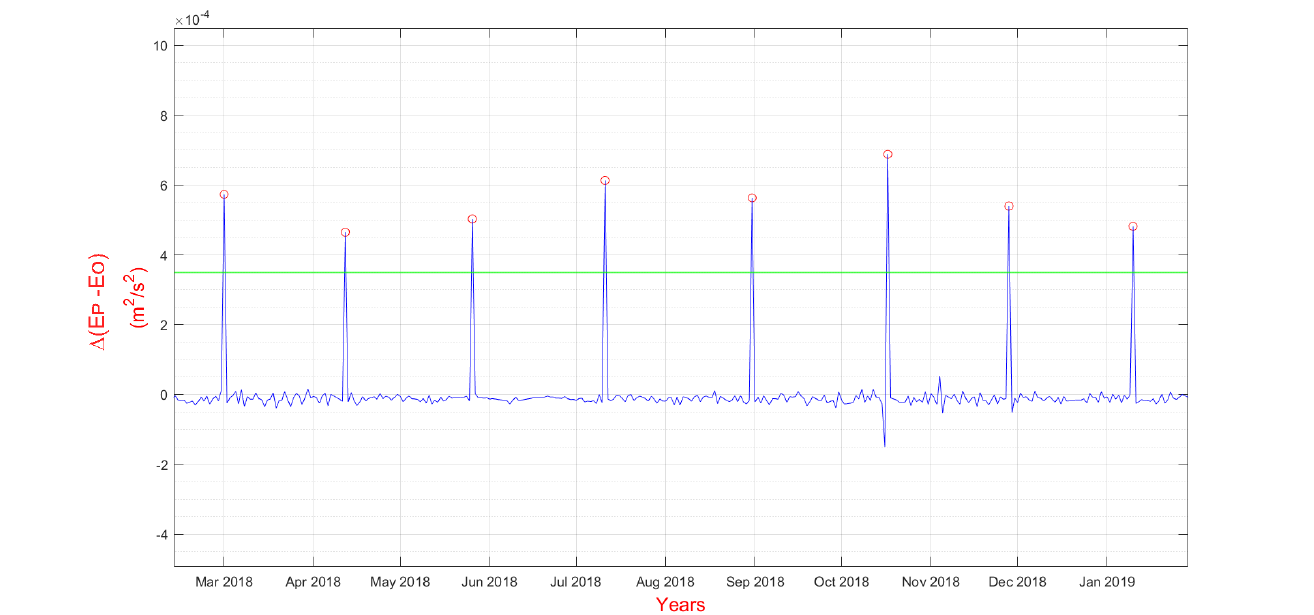
Figure 9. TDRS-3’s difference between the propagated and the observed inclination. The horizontal green line is the detection limit; the horizontal green line represents the threshold limit and the red circles represent potential maneuvers detected by this